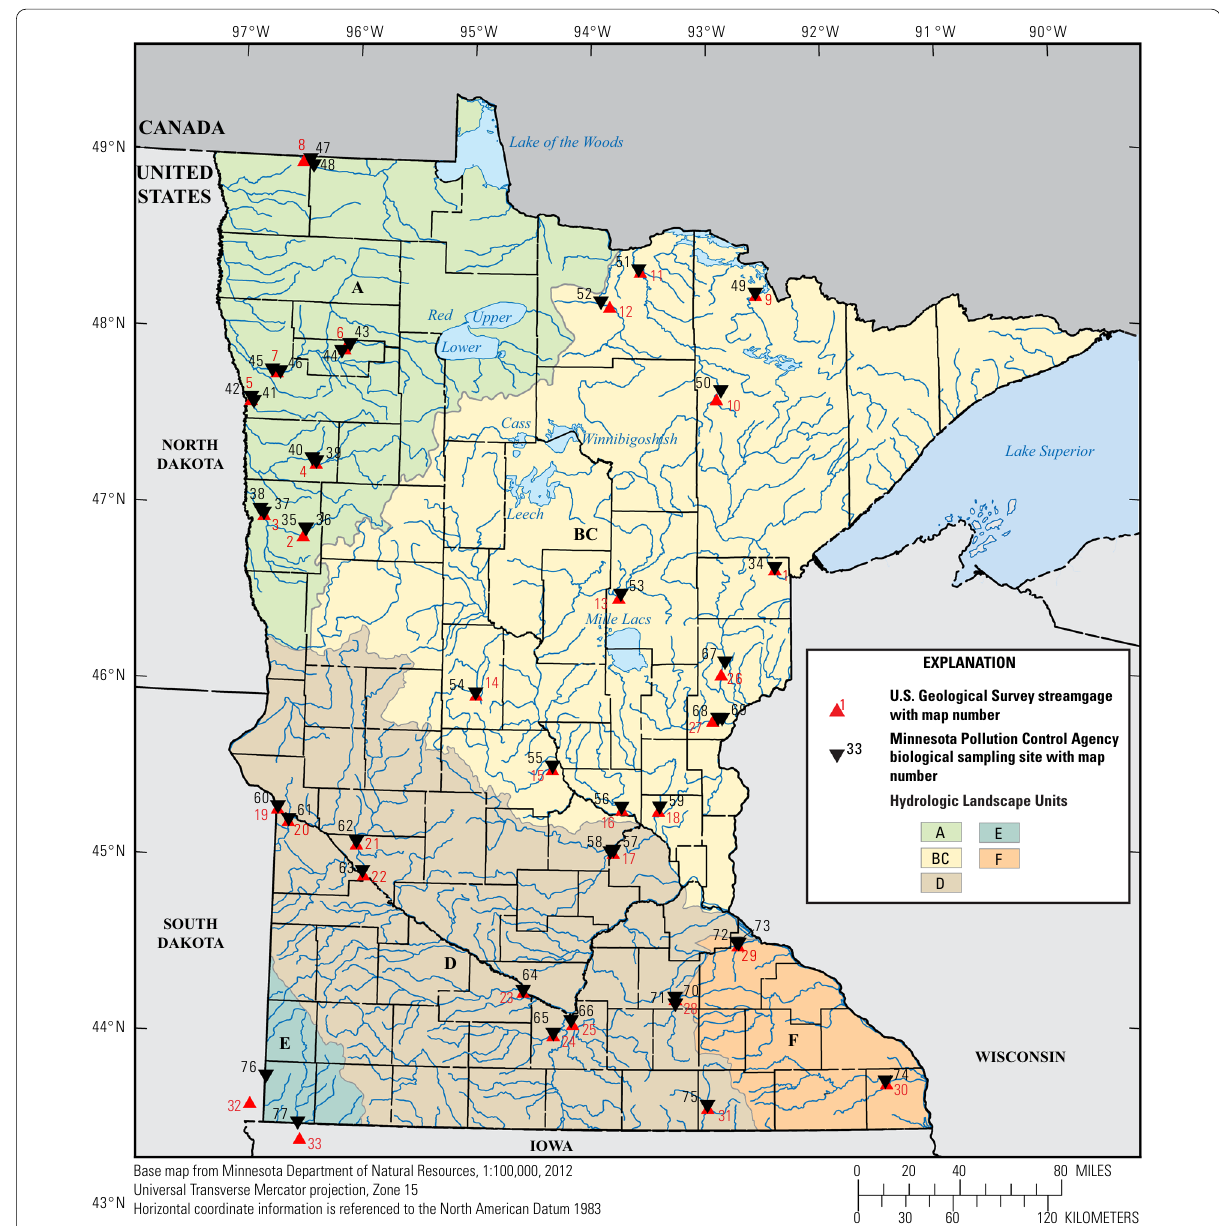
Fig. 1 Map illustrating paired U.S. Geological Survey streamgages and Minnesota Pollution Control Agency biological sampling sites across 5 hydrologic landscape units previously identified for Minnesota (Ziegeweid et al. 2015); numbers assigned to sites represent map numbers presented in a published companion data release (Krall et al.